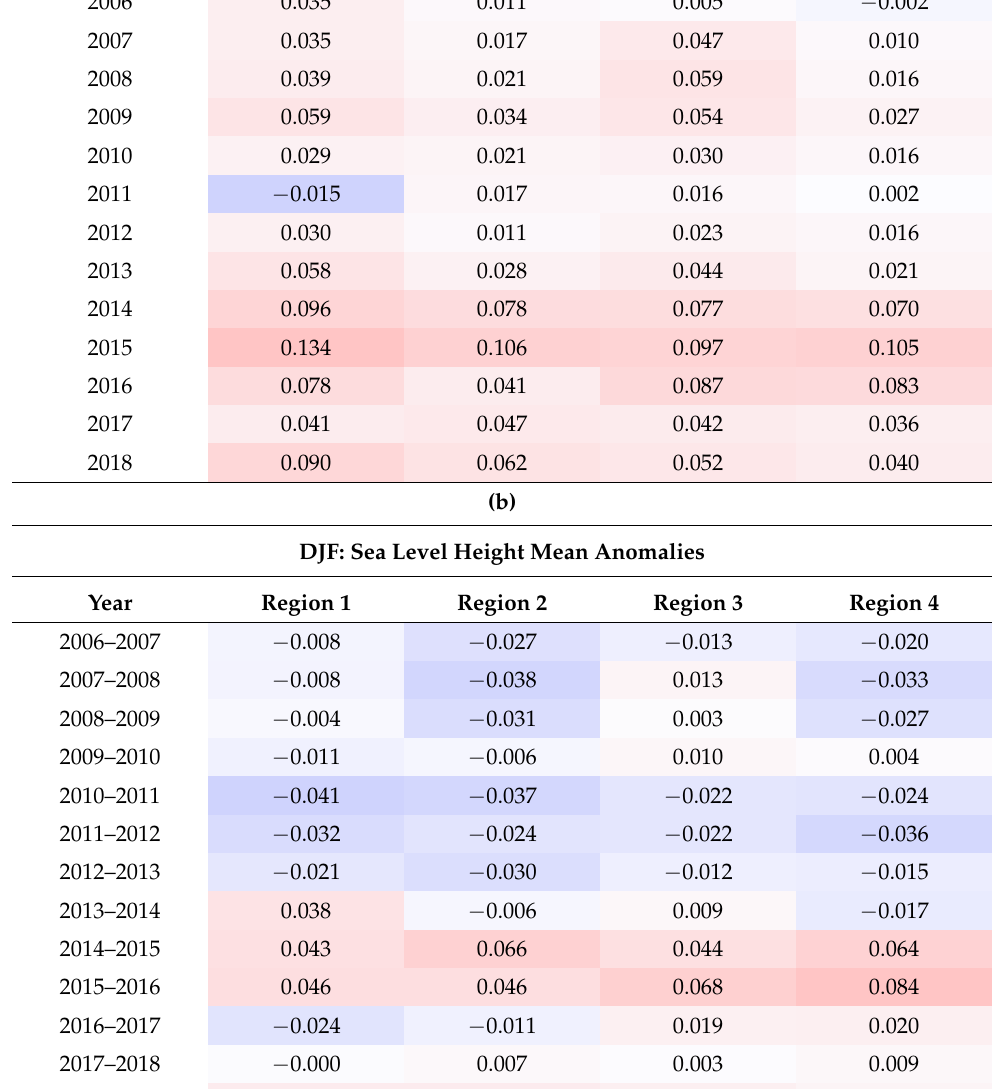
Table 2. Quantitative analysis of sea level heights anomalies from 2006 through 2019 for ( a ) SON and ( b ) DJF. Color range in table reflects each region seasonal mean as seen in Figure 7. (a) SON: Sea Level Height Mean Anomalies Region